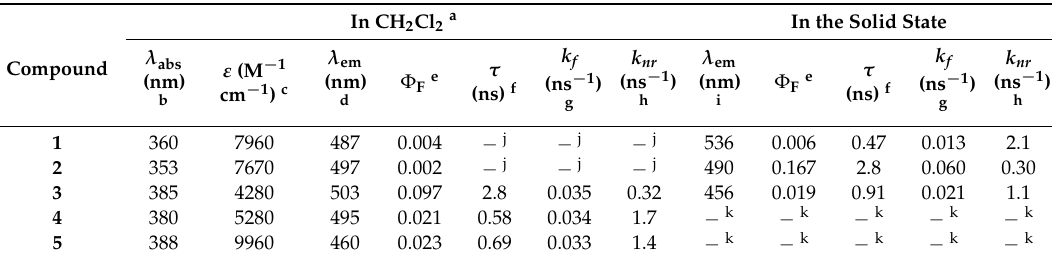
Table 1. Photophysical Properties of Compounds 1 – 5 .